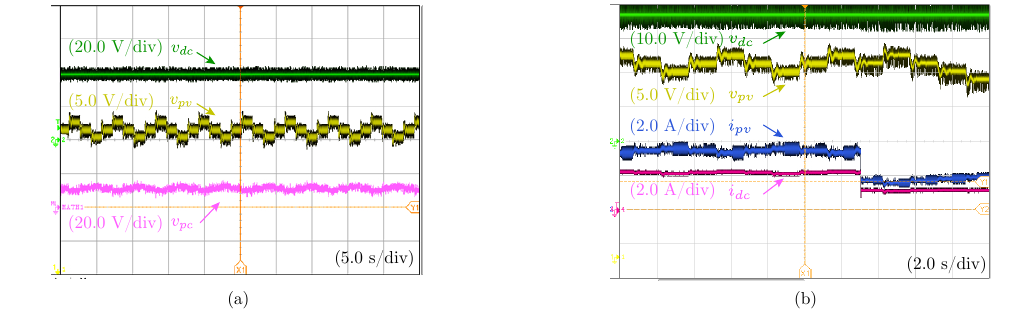
Figure 7. Maximum Power Point Tracking (MPPT) performance in the Step-Up based PPC: ( a ) under constant solar irradiation; ( b ) under a solar irradiation